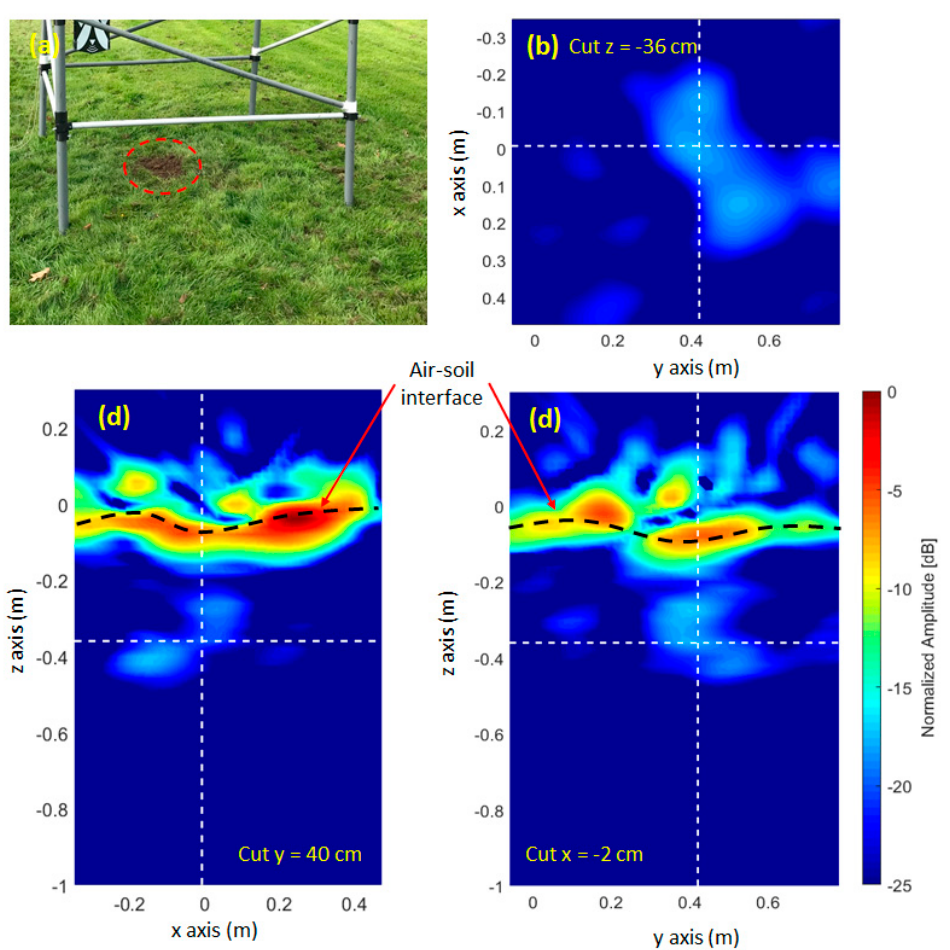
Figure 10. Picture of the scenario under test. Dashed red line indicates the placement of the filled hole with no objects in it ( a ). Reflectivity normalized amplitude, in dB: cut z = − 36 cm ( b ), cut y = 40 cm ( c ), cut x = − 2 cm ( d ).